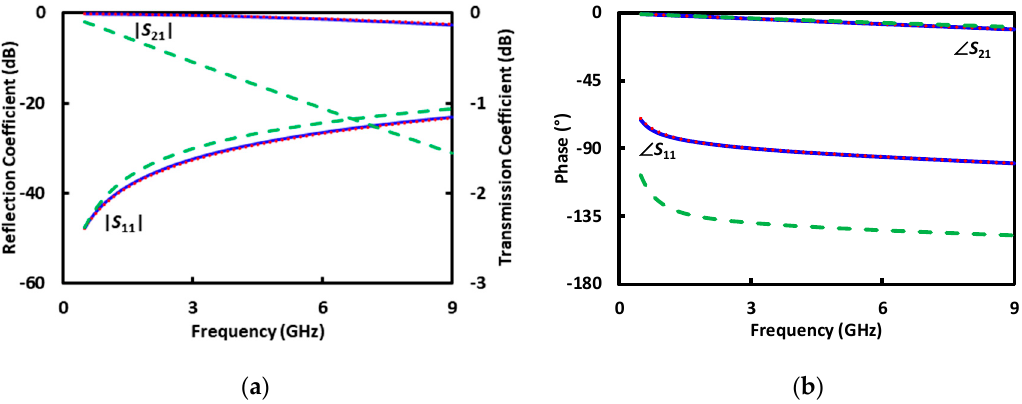
Figure 6. Simulated ( a ) magnitude and ( b ) phase of S parameters of the 200 μ m long CPW section under DI ( ― ), sucrose ( · · · ), or RPMI ( - - - ) solutions.